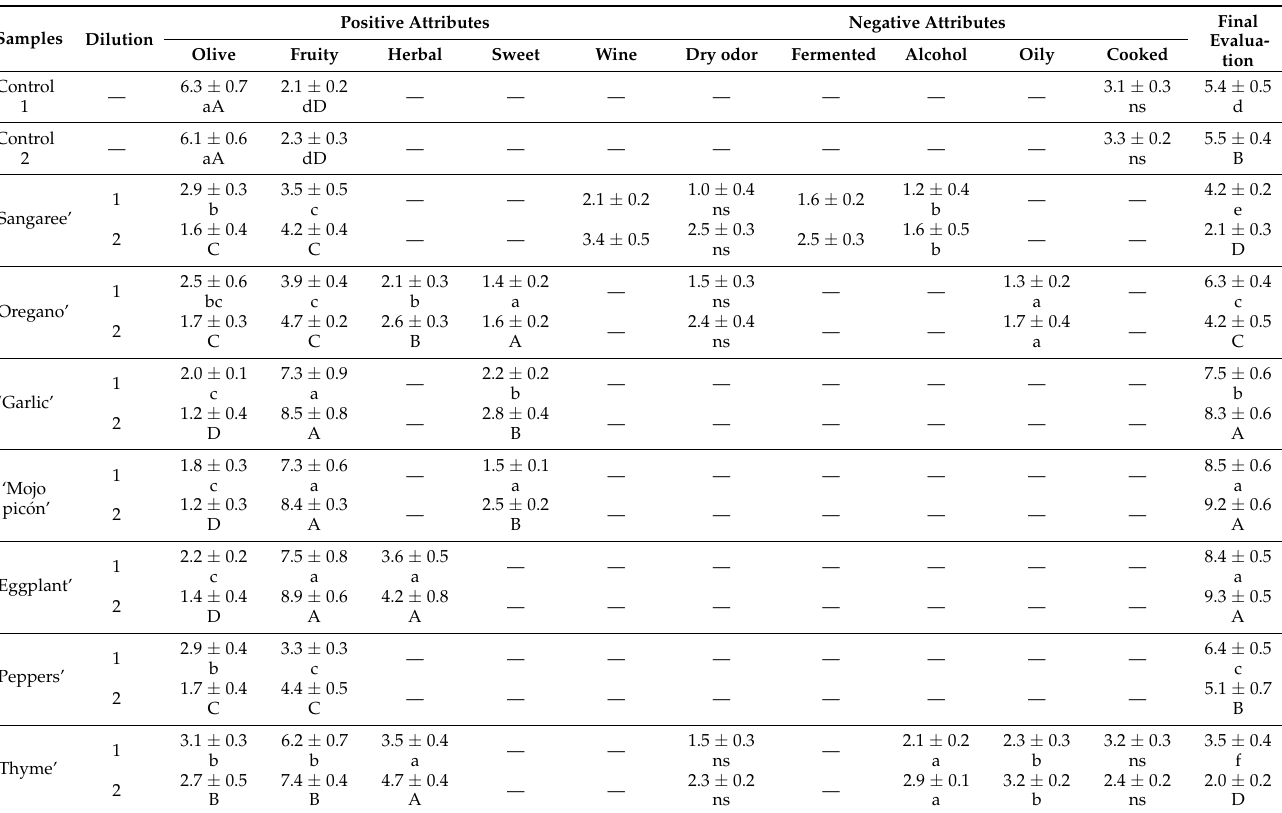
Table 4. Sensory analysis of stuffed Californian-style black olives with the addition of different concentrations of hydrocolloids Different lowercase letters mean a statistically significant difference between dilution 1 stuffed aromas (Tukey’s test p < 0.05). Different capital letters mean significant differences between the dilution 2 stuffed aromas (Tukey’s test p <